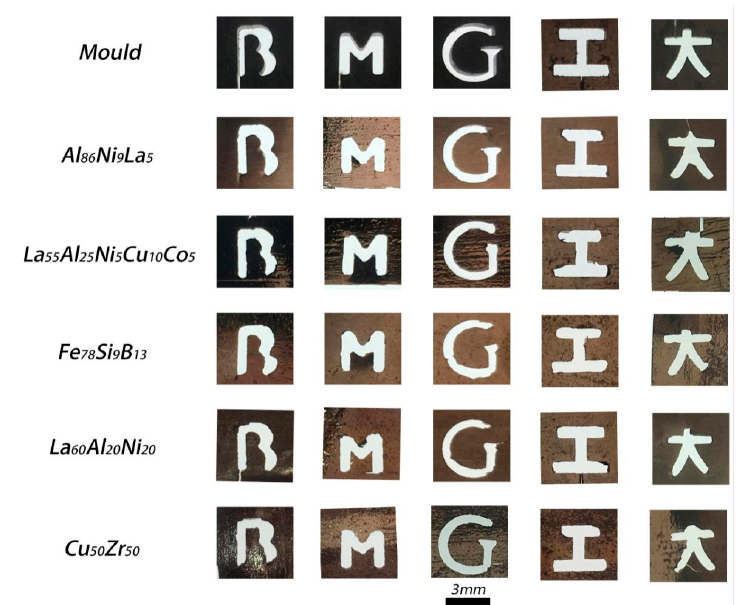
Figure 5. The photographs of amorphous alloys after shear punching of amorphous alloys under high-frequency vibration.